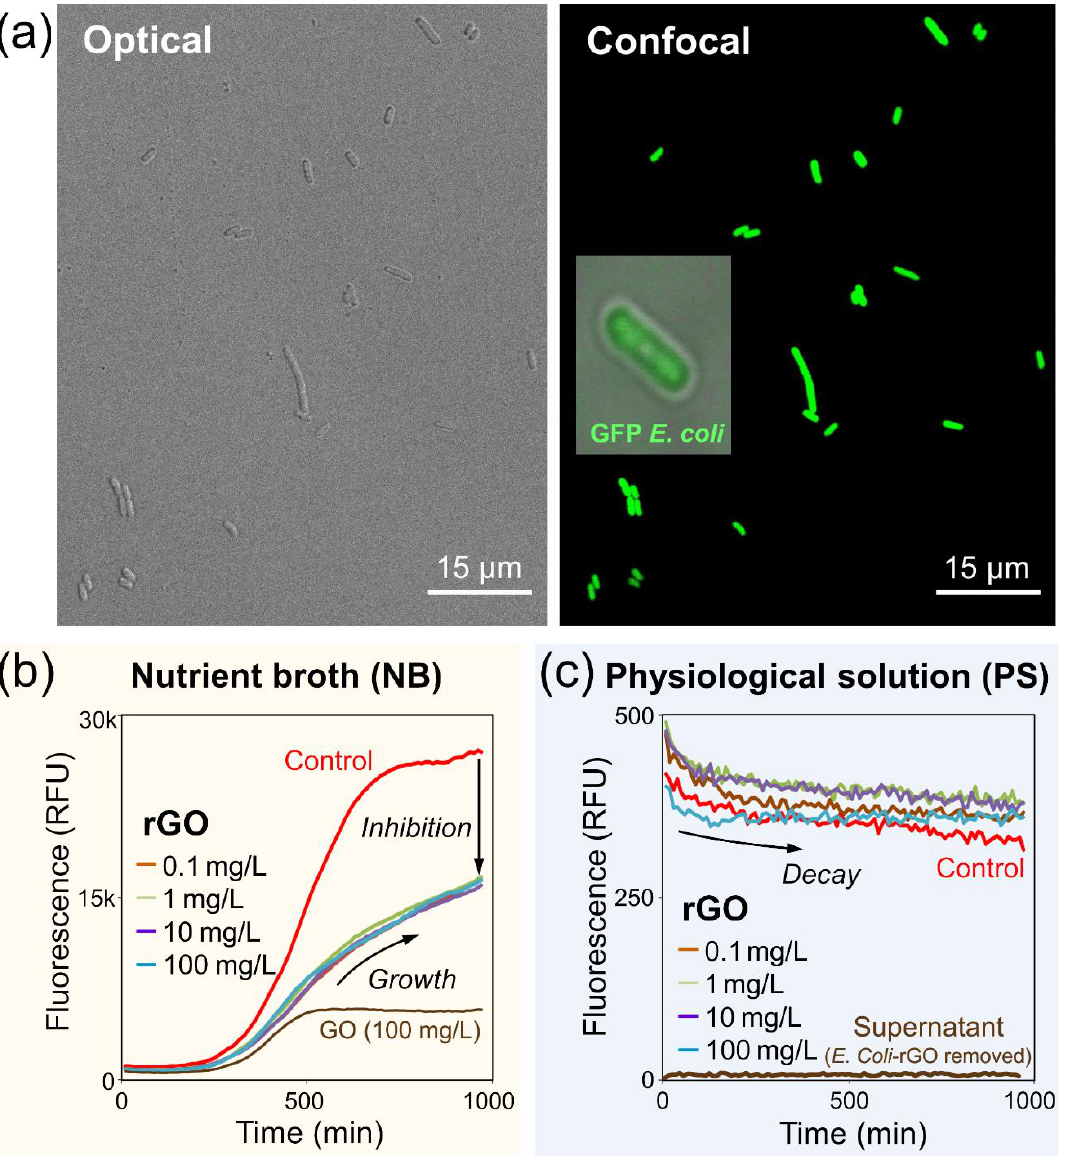
Figure 3. Effect of rGO on E. coli bacteria in nutrition broth (NB) and physiological solution (PS) media. (a) Optical (left) and confocal microscopy (right) images of suspensions of green fluorescent protein (GFP) expressing E. coli bacteria. The inset in the right panel shows magnified image of an individual E. coli by confocal microscopy. (b,c) Fluorescence of GFP E. coli bacteria in NB (b) and PS (c) after the addition of rGO at concentrations ranging from 0.1 to 100 mg/L. The red curves in (b,c) show the fluorescence of E. coli in control samples, in which the bacteria were measured in NB and PS, respectively, without the addition of rGO. The brown curve in (b) shows fluorescence of GFP E. coli bacteria in NB after the addition of 100 mg/L GO solution. The brown curve in (c) shows no fluorescence from the supernatant decanted from the E. coli -rGO colloidal solution in PS , suggesting that the bacteria aggregated with the rGO sheets and were removed from solution. The fluorescence in panels (b) and (c) is shown in the same relative fluorescence units (RFU).